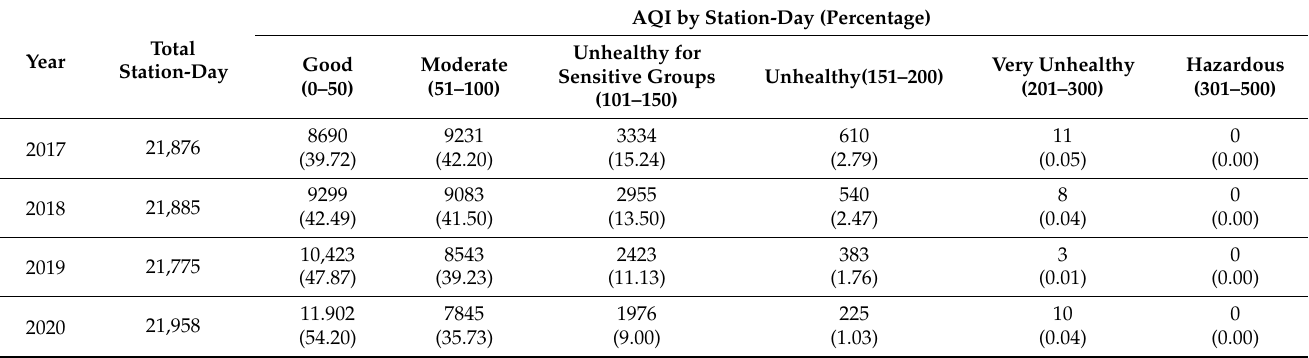
Table 4. Status of Taiwan’s air quality index (AQI) in recent years (2017–2020) 1